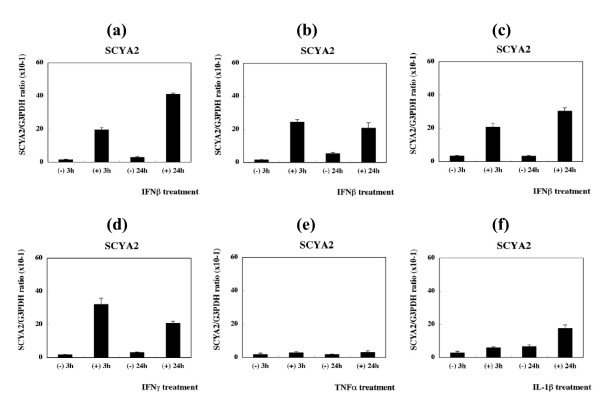
Real-time RT-PCR analysis of SCYA2 expression in PBMC. See the footnote of Figure 1. The panels represent the expression of SCYA2 in (a) #1, IFNβ; (b) #2, IFNβ; (c) #3, IFNβ; (d) #1, IFNγ; (e) #1, TNFα; and (f) #1, IL-1β.